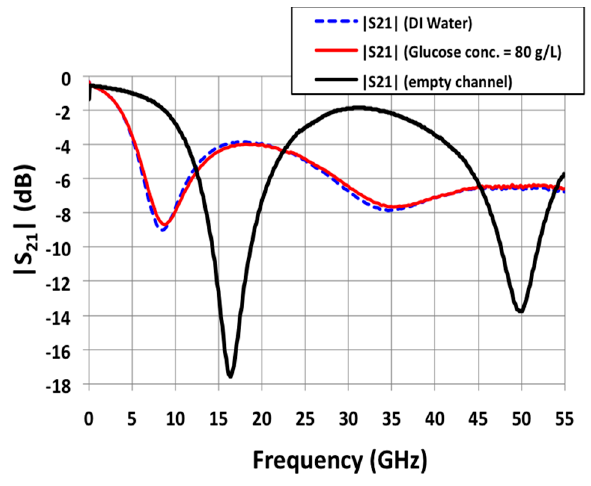
Figure 3. Measured S21 spectra in the frequency range [0; 55] GHz for deionized water (reference liquid in this study) and a glucose solution at 80 g/L.